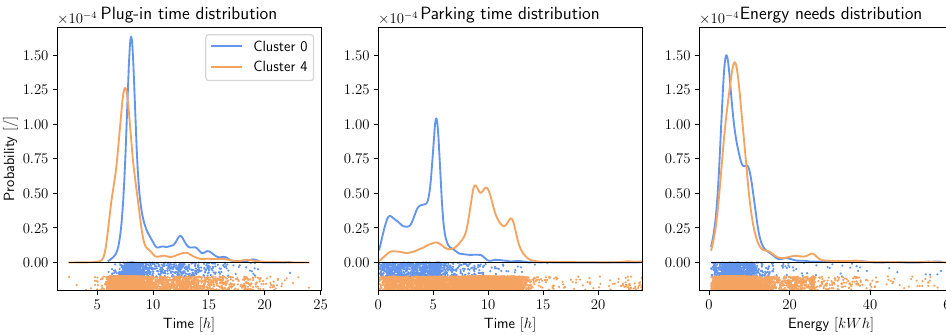
Figure 2. Number of clusters identification for the k-means clustering algorithm.